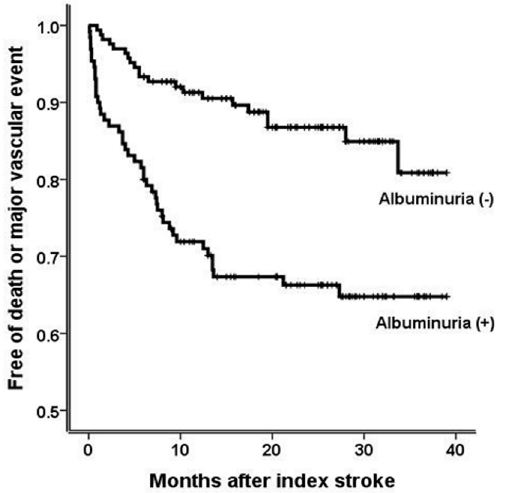
Fig 1. Kaplan – Meier curves for composite adverse events (mortality or major vascular events). The patients with albuminuria (urine albumin-to-creatinine ratio ≥ 30 mg/g) had a significantly higher rate of composite adverse events than the patients without albuminuria ( P < 0.001 by log-rank